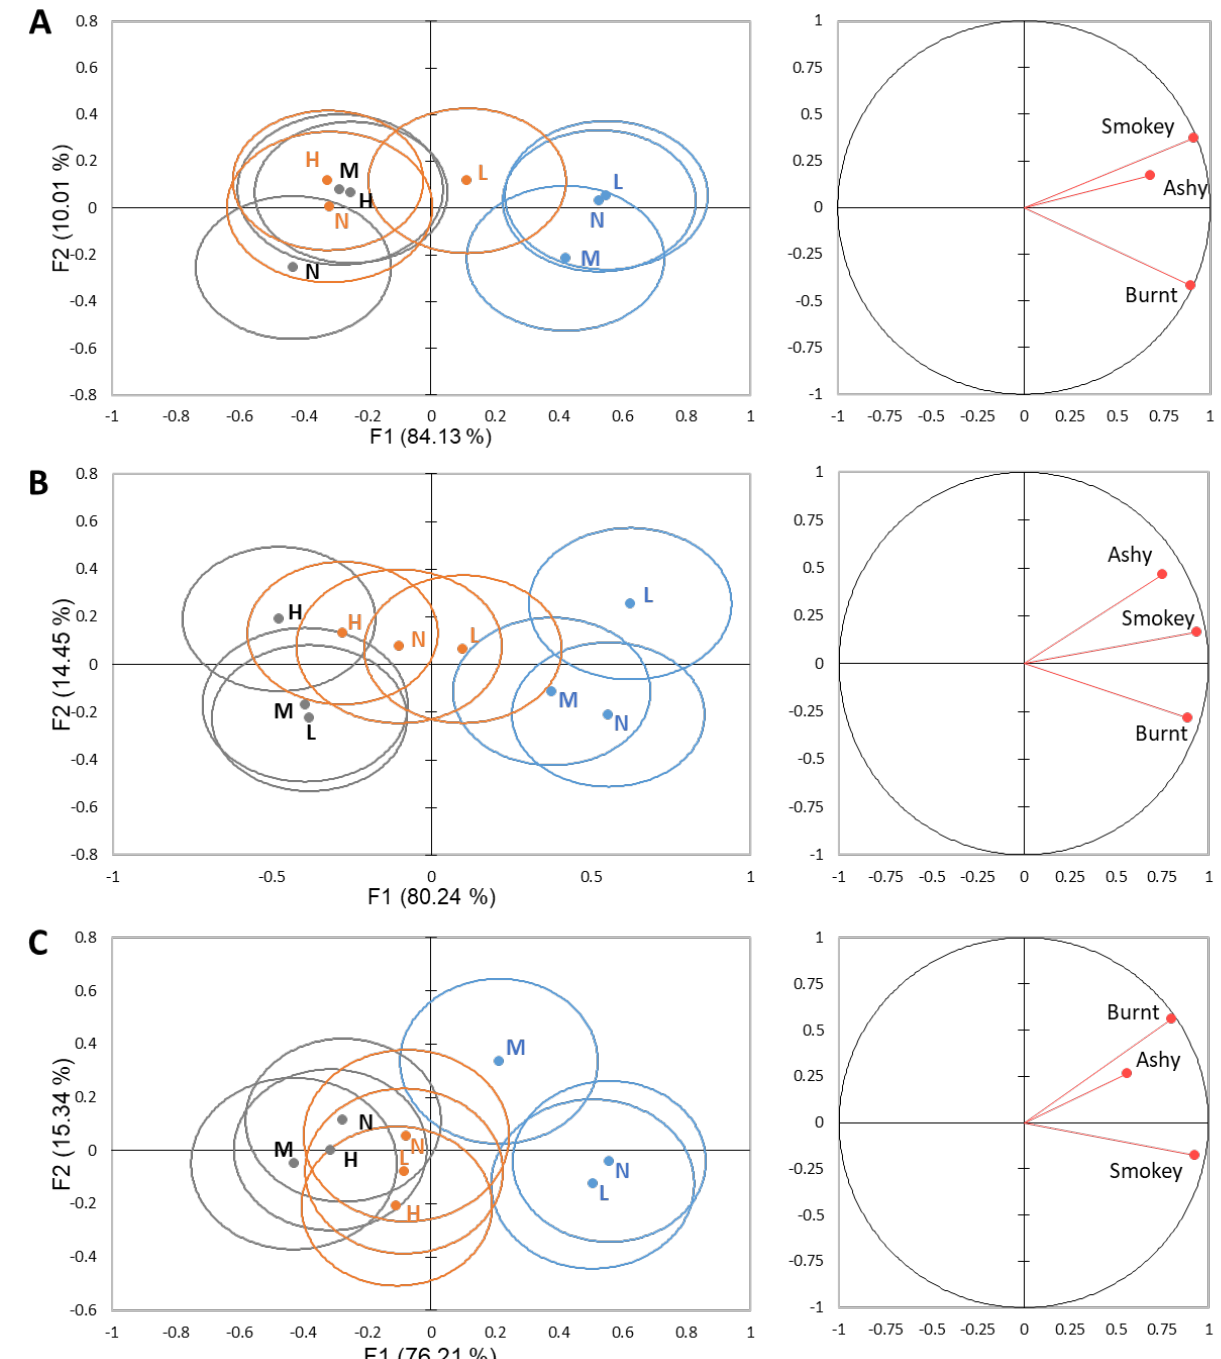
Figure 6. Separation of high smoke phenol (blue), moderate smoke phenol (orange), and low smoke phenol (grey) wines based on preceding sample (low smoke sample—L, moderate smoke sample—M, low smoke sample—L, and no sample—N) within a set at 0 s based on DA from smoke-related attributes for each rinse system: ( A ) water, ( B ) pectin, and ( C ) mouthwash. Ellipses represent a 95% confidence interval, around the means.